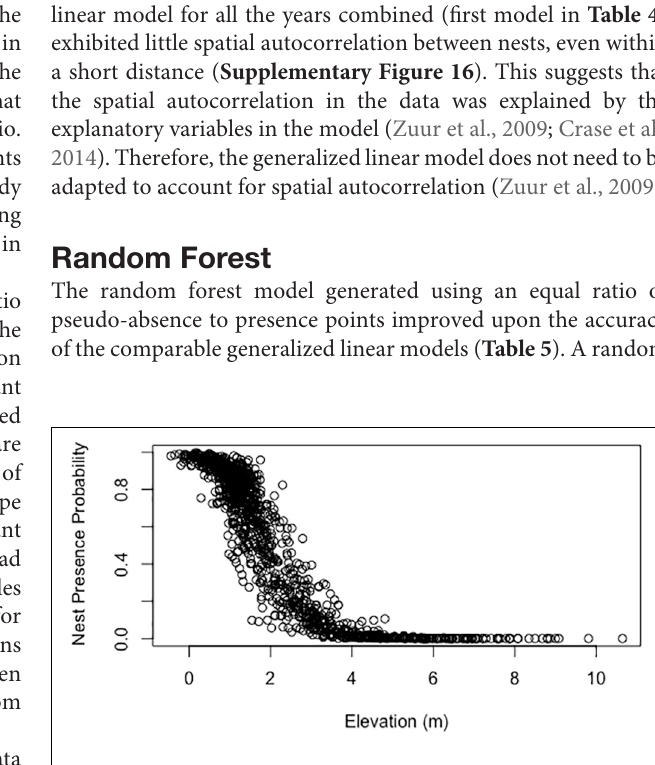
K-fold R-squared cross-validation